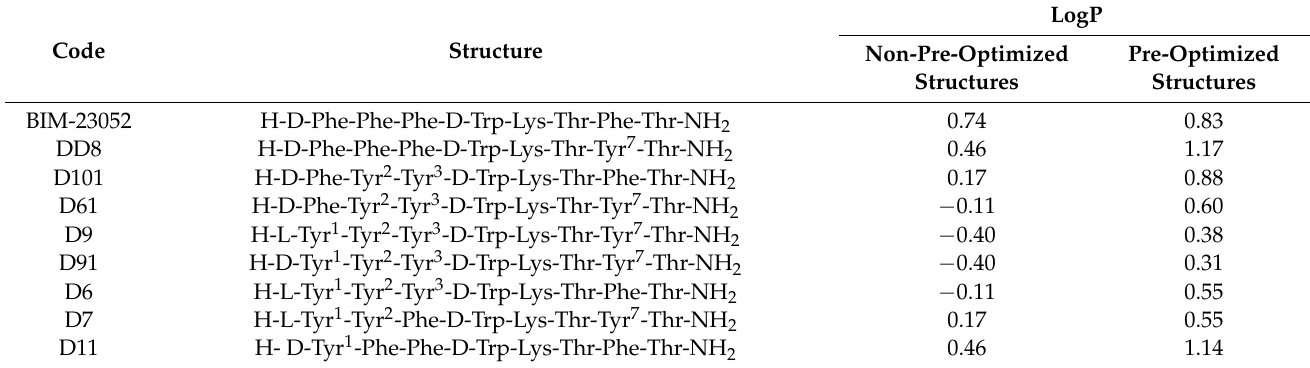
Table 5. LogP values of targeted structures.